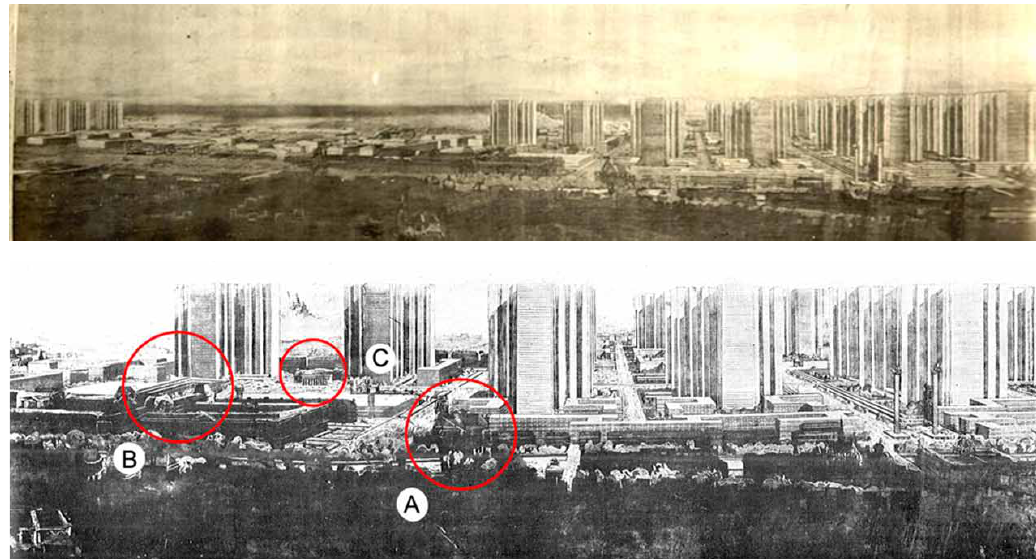
figs 18a–18b Diorama of Plan Voisin and fragment. Version Urbanisme and Œuvre Complète. ©